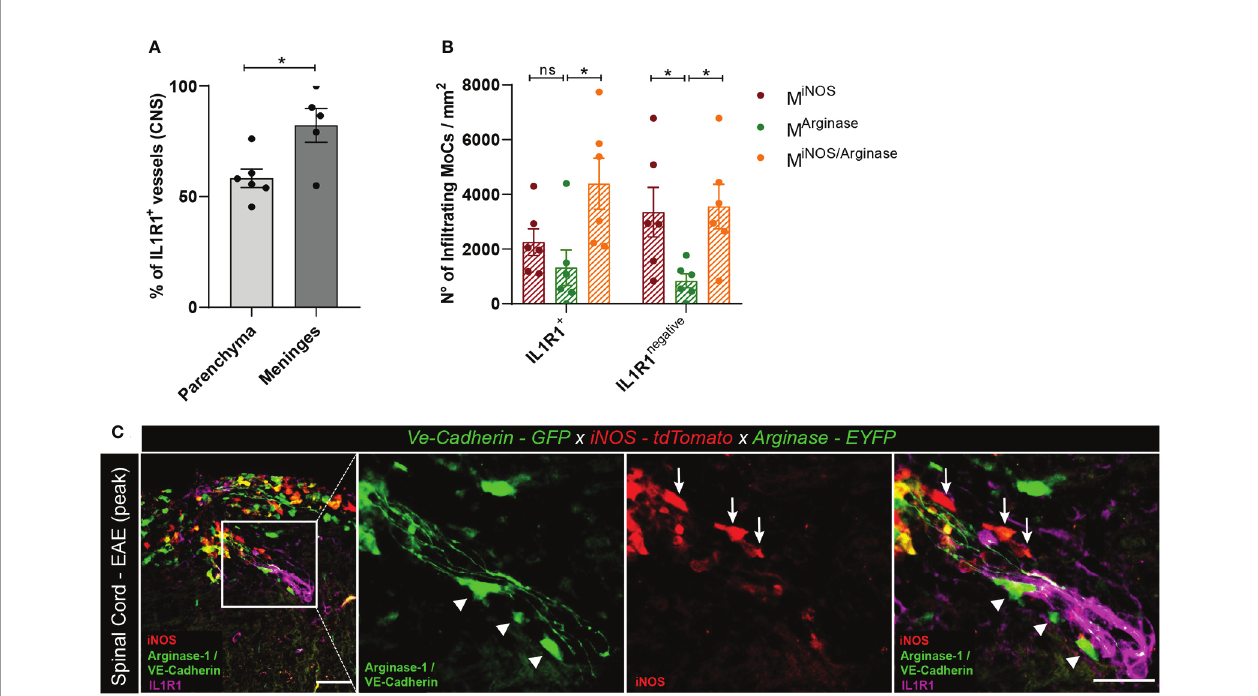
FIGURE 5 | Polarized MoC density around IL1R1 + and IL1R1 negative vasculature during EAE. (A) Relative percentage of IL1R1 + and IL1R1 negative vessels in the in fl amed spinal cord parenchyma (n=6) and leptomeninges (n=5) of VE-cadherin-GFP x iNOS-tdTomato x Arginase-EYFP mice induced with EAE (3 days after disease onset). A higher number of IL1R1 + vessels were detected in the meninges compared to parenchyma, unpaired t test (p=0.018, *p < 0.05). The total amount of vessels in tissue sections was assessed using the GFP positivity of VE-Cadherin expressing endothelial cells. Immunostaining with IL1R1-speci fi c antibody revealed receptor expression. (B) Density of M iNOS , M Arginase and M iNOS/Arginase cells surrounding IL1R1 + and IL1R1 negative vasculature of VE-cadherin-GFP x iNOS- tdTomato x Arginase-EYFP mice induced with EAE (6 mice, 3 days after disease onset). The quanti fi ed areas include tissue at a maximum distance of 20 µm from the endothelial GFP signal. Data represented as mean ± SEM. In the proximity of IL1R1 + vessels, a higher density of M iNOS/Arginase cells (Mean = 4389, SEM = 933.6) are detected as compared to M Arginase (Mean = 1321, SEM = 650.9) (p = 0.136) and to M iNOS (Mean = 2254, SEM = 490.6) (p = 0.105). In contrast, in the proximity of IL1R1 negative vessels, a higher number of M iNOS (Mean = 3352, SEM = 906.1) (p=0.048) and M iNOS/Arginase cells (Mean = 3556, SEM = 812.3) (p=0.031) are detected as compared to M Arginase cells (Mean = 839.6, SEM = 258.0). Two-way ANOVA with Tukey´s multiple comparisons test, *p < 0.05, ns, not signi fi cant. (C) Representative confocal images of spinal cord tissue from VE-cadherin-GFP x iNOS-tdTomato x Arginase-EYFP mice induced with EAE (3 days after disease onset). tdTomato indicates M iNOS , EYFP M Arginase cells and GFP VE-cadherin expression at BBB endothelial cell junctions. Immunostaining with IL1R1-speci fi c antibody reveals IL1R1 receptor expression. Arrowheads highlight M Arginase cells and arrows indicate M iNOS cells in the perivascular space and in the tissue surrounding the vessel. Scale bar, 50 m m; magni fi ed regions, scale bar 30 m